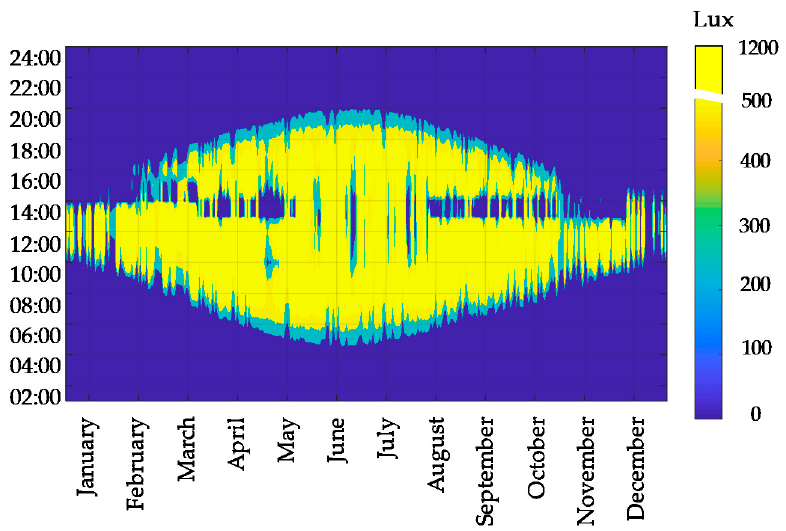
Figure 12. Annual daylight availability in an office zone with south orientation in Stockholm.